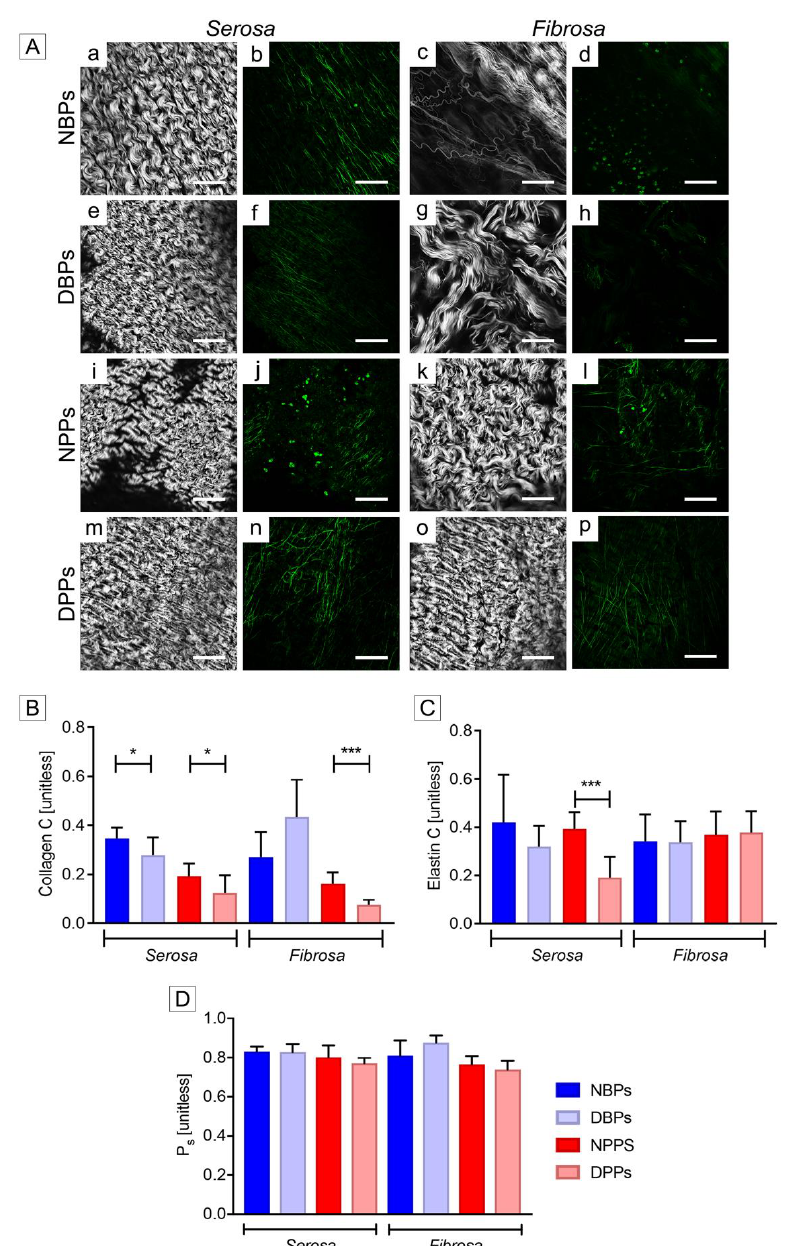
Figure 4. Extracellular matrix (ECM) pattern of bovine and porcine pericardia before and after TRICOL decellularization. ( A ) Second harmonic generation and autofluorescence. In the decellularized serosa (e and f for bovine; m and n for porcine), collagen and elastin maintained the tight organization of the native condition (a and b for bovine; i and j for porcine). Bovine acellular fibrosa (g and h) showed an unaltered collagen loosen distribution with respect to native tissue (c and d). A more crimped and wavy appearance was shown in the decellularized porcine counterpart (k and l for native and o and p for decellularized). Magnification bars: 100 µ m. ( B ) Collagen coherency (C). C of collagen bundles decreased significantly for decellularized serosa of both species and decellularized porcine fibrosa with respect to native tissues. ( C ) Elastin coherency (C). C of elastin fibers was significantly higher in native porcine serosa samples than in decellularized ones. ( D ) Straightness parameter (P s ) of collagen bundles. No significant modifications were revealed after decellularization for the P s of collagen, apart from bovine fibrosa. For B , C and D , data are presented as mean ± standard deviation (SD). * p < 0.05; *** p < 0.001. NBP = Native Bovine Pericardium, DBP = Decellularized Bovine Pericardium, NPP = Native Porcine Pericardium, DPP = Decellularized Porcine Pericardium, C = coherency, and P s = straightness parameter.